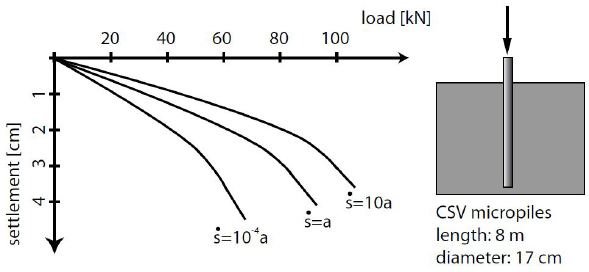
Figure 3: Results of displacement-controlled load tests on floating CSV (Combined Soil Stabilization with Vertical Columns) micropiles after Vermeer and Leoni [5]. is the penetration rate and a is its reference